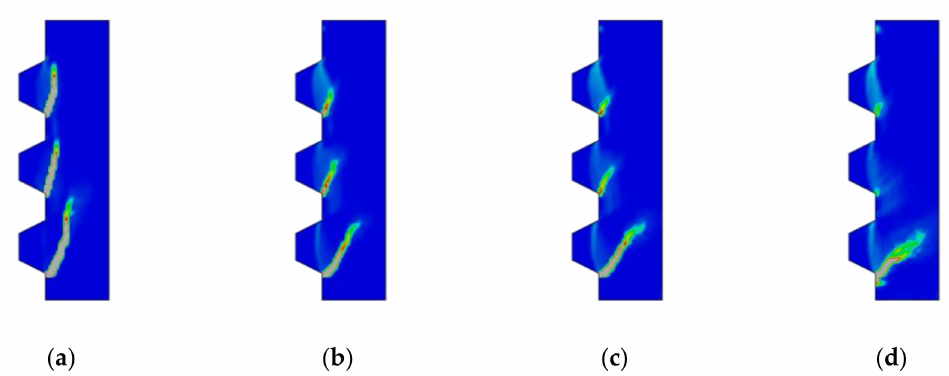
Figure 11. Crack pattern evolution in a 3-keyed joint with V f = 0.0%: ( a ) σ n = 0.5 MPa; ( b ) σ n = 1.5 MPa;